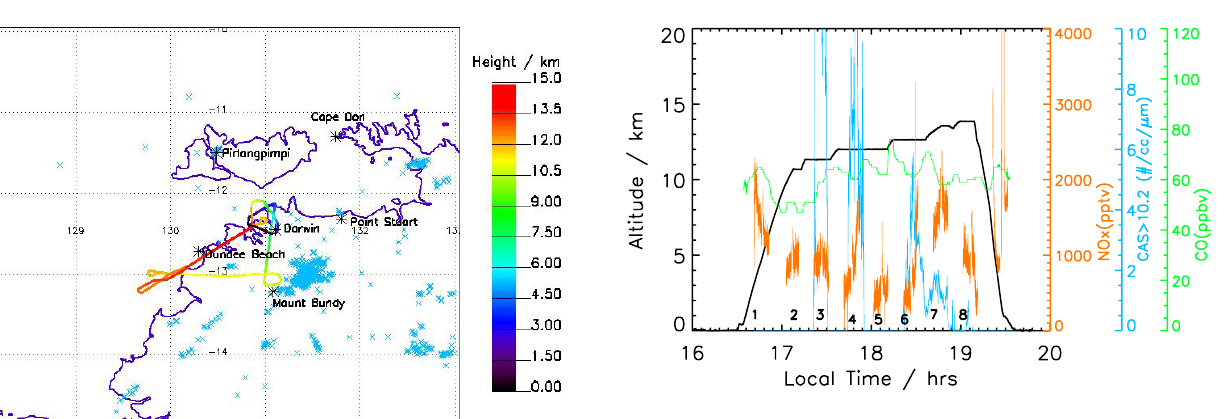
Fig. 4. Time series (in hours local time) of Egrett data on the 22 January flight: altitude (black line), CO (green), NO x (orange) and particles larger than 10.2 µ m (light blue line), used an indicator of in-cloud conditions, where N > 1 indicates cloud. The numbers cor- respond to the different transects in the flight where NO x was mea- sured.